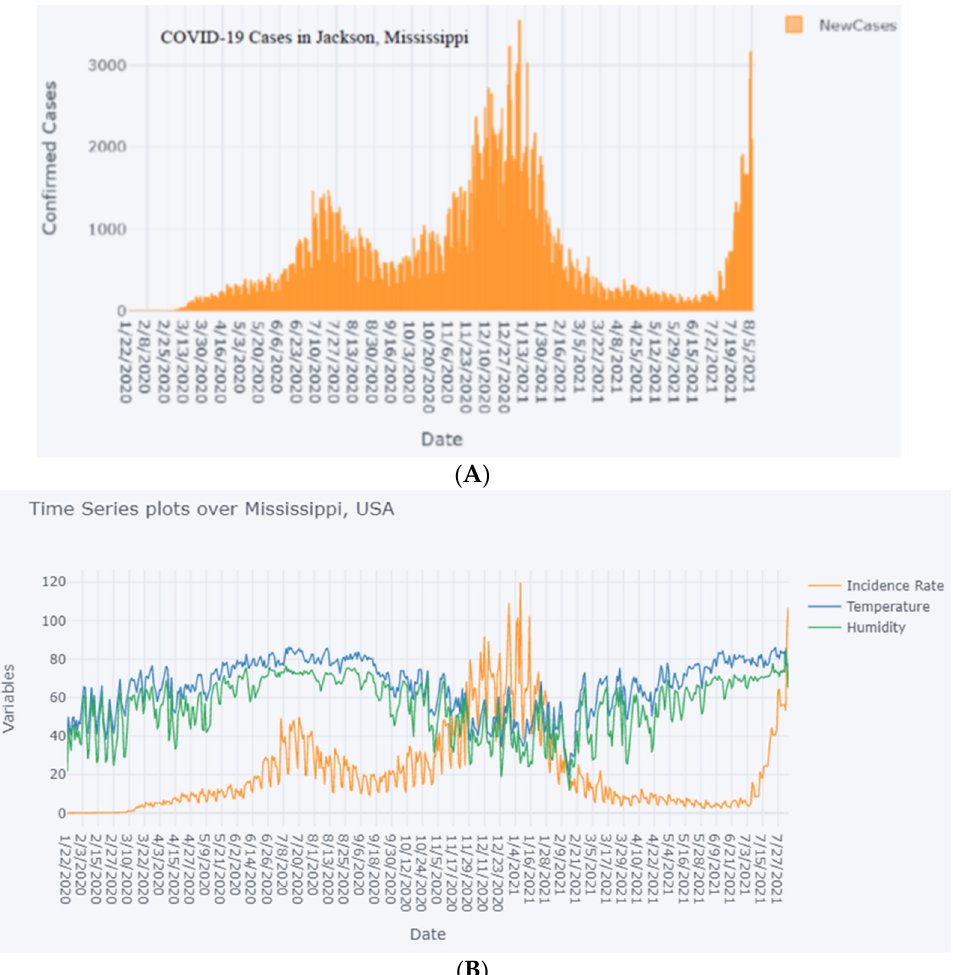
Figure 1. ( A ) Time series of COVID-19 cases (new incidence) for Mississippi 22 January 2020 to 4 August 2021. ( B ) Time series of COVID-19 incidence rate, temperature, and humidity for Mississippi